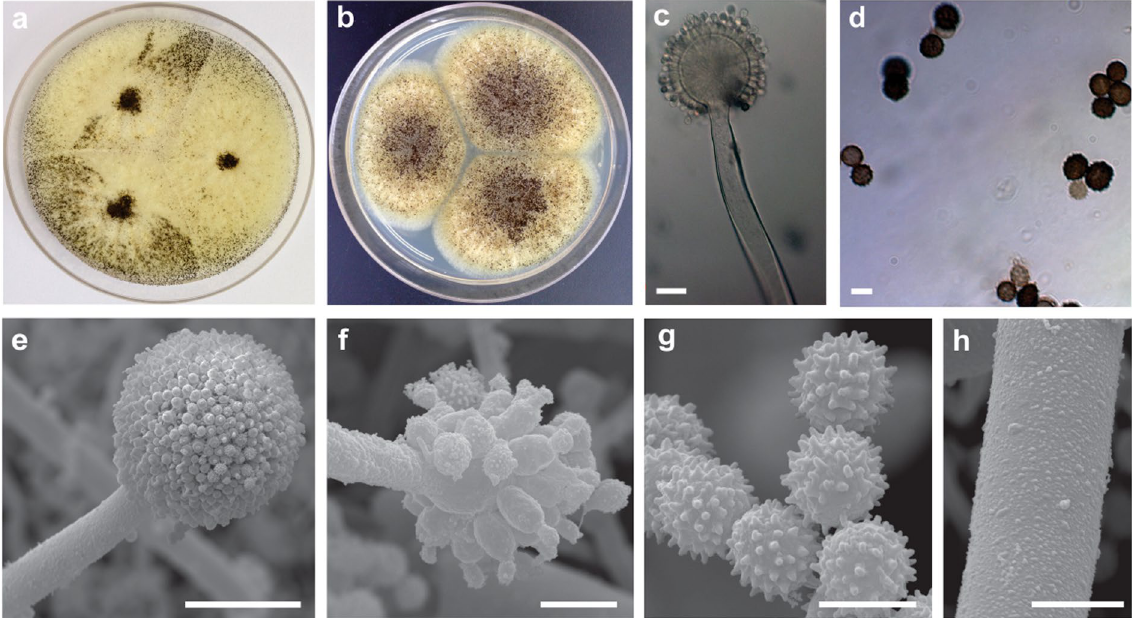
Figure 4. Aspergillus labruscus sp. nov. CCT 7800. ( a ) Colonies on CYA, ( b ) colonies on MEA, ( c ) conidiophores under light microscopy, ( d ) conidia under light microscopy, ( e , f ) conidiophores as seen using SEM, ( g ) conidia as seen using SEM, ( h ) stipe as seen using SEM. Bars, 10 µ m ( c , f and h ), 5 µ m ( d and g ), 50 µ m ( e